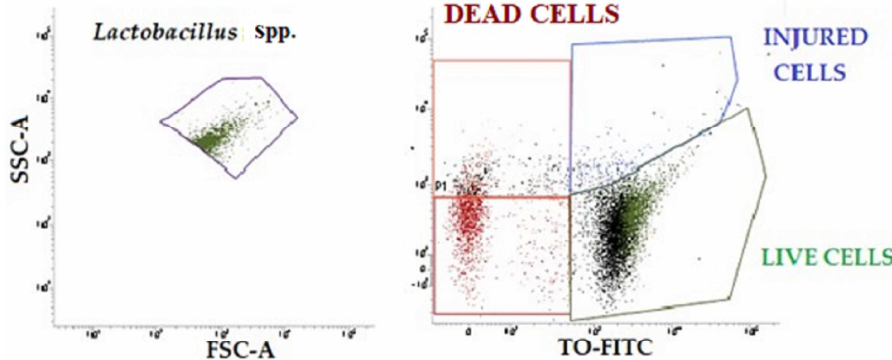
Figure 3. Representative dot-plots of food supplement 2 analyzed by flow cytometry. Two different graphs are shown for both Bifidobacterium spp. and Lactobacillus spp.: one represents the morphological features of each population, while the other on the right represents bacteria vitality, (red dots are dead cells; blue dots are injured cells; green dots are live cells). SSC-A: Side Scatter- Area; FSC-A: Forward Scatter-Area; PI-PerCP: Propidium Iodide-Peridinin-Chlorophyll-Protein; TO-FITC: Thiazole Orange-Fluorescein isothiocyanate.